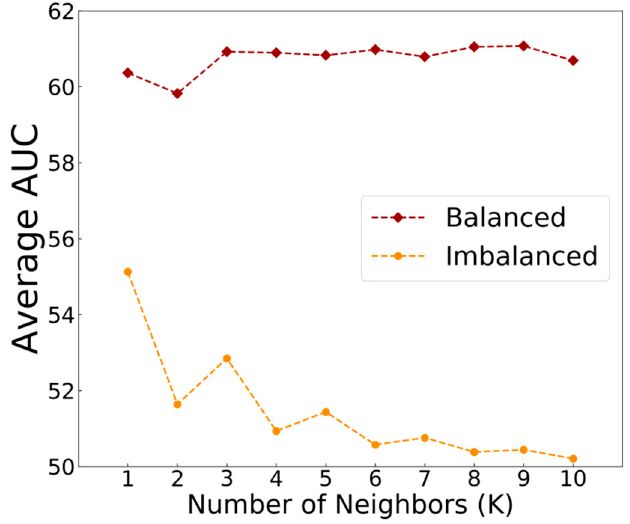
Figure 4. Average AUC when the value of K is changed in KNN classification on imbalanced data and on balanced data using SMOTE.